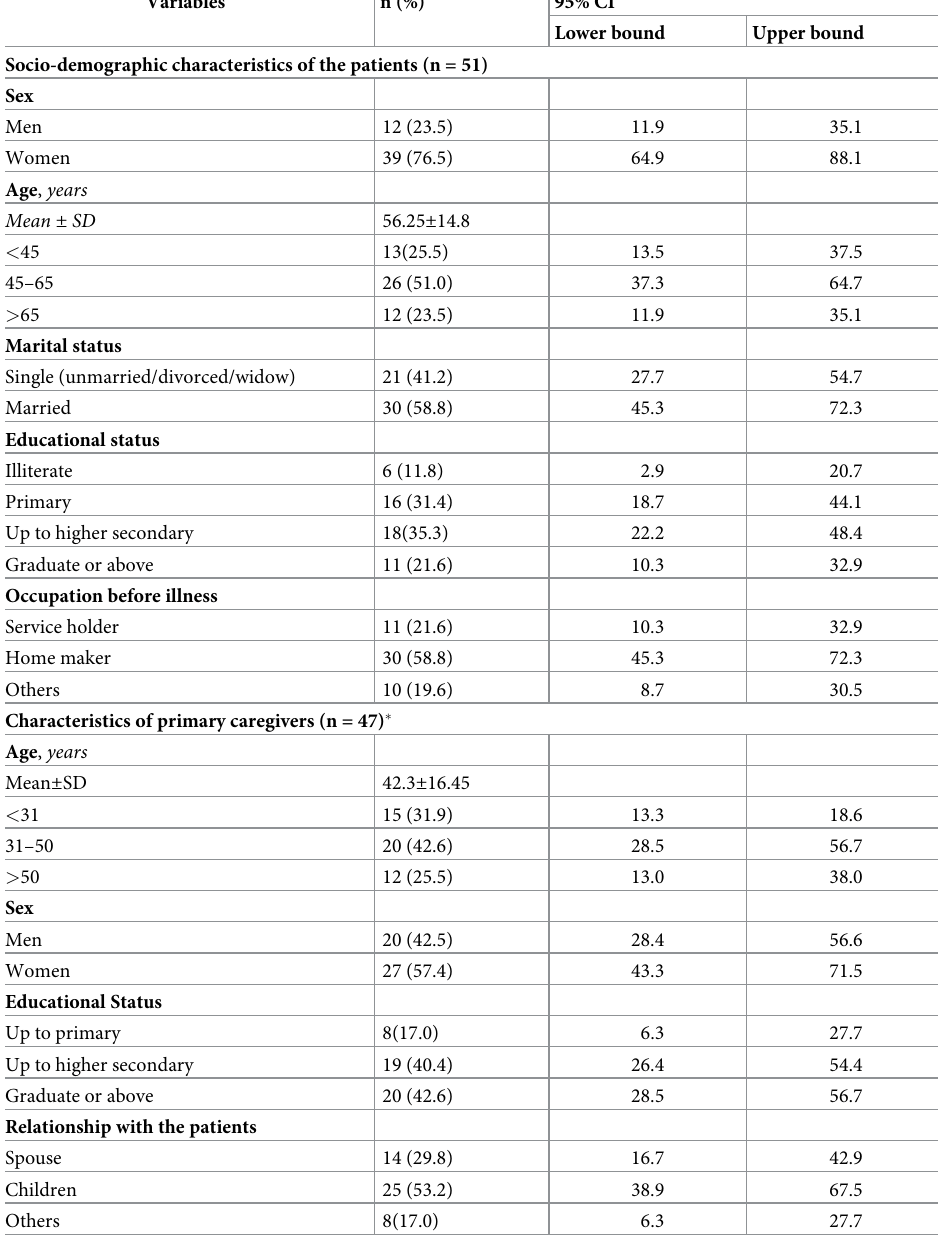
Table 1. Socio-demographic characteristics of the patients and primary caregivers. Variables n (%) 95% CI Lower bound Upper bound Socio-demographic characteristics of the patients (n =